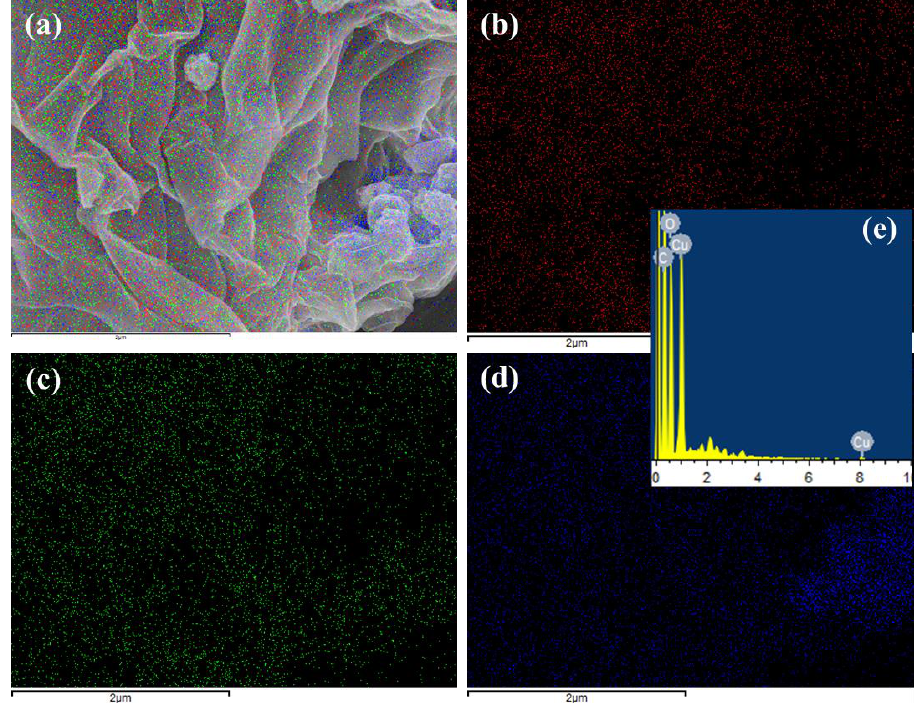
Figure 3. Elemental mapping images of ( a ) GN@CR-Cu; ( b ) C; ( c ) O; ( d ) Cu; and ( e ) EDS spectrum of GN@CR-Cu. spectrum of